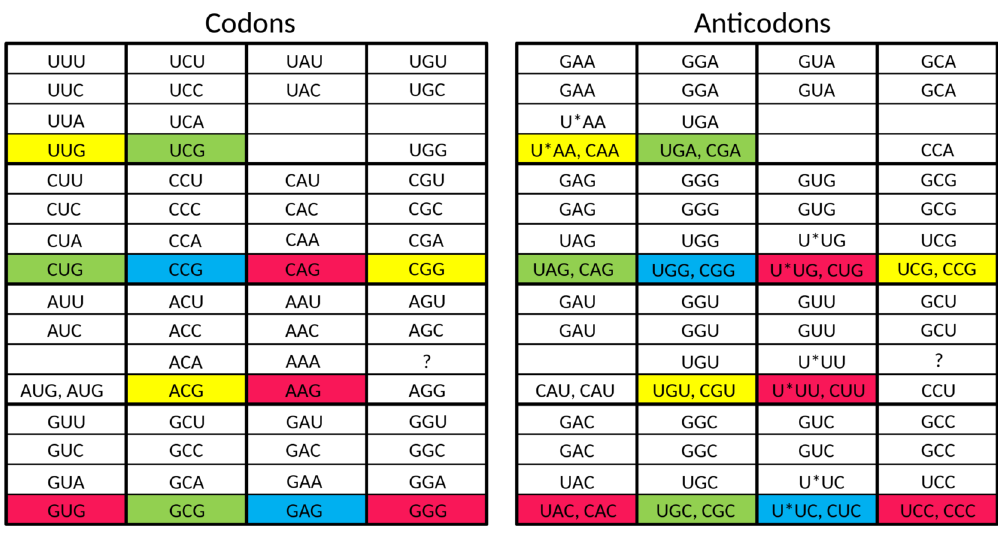
initiator methionine and elongator methionine. Red, yellow, green, and blue are used to indicate the codons where changes happened compared to the situation in the previous figure.